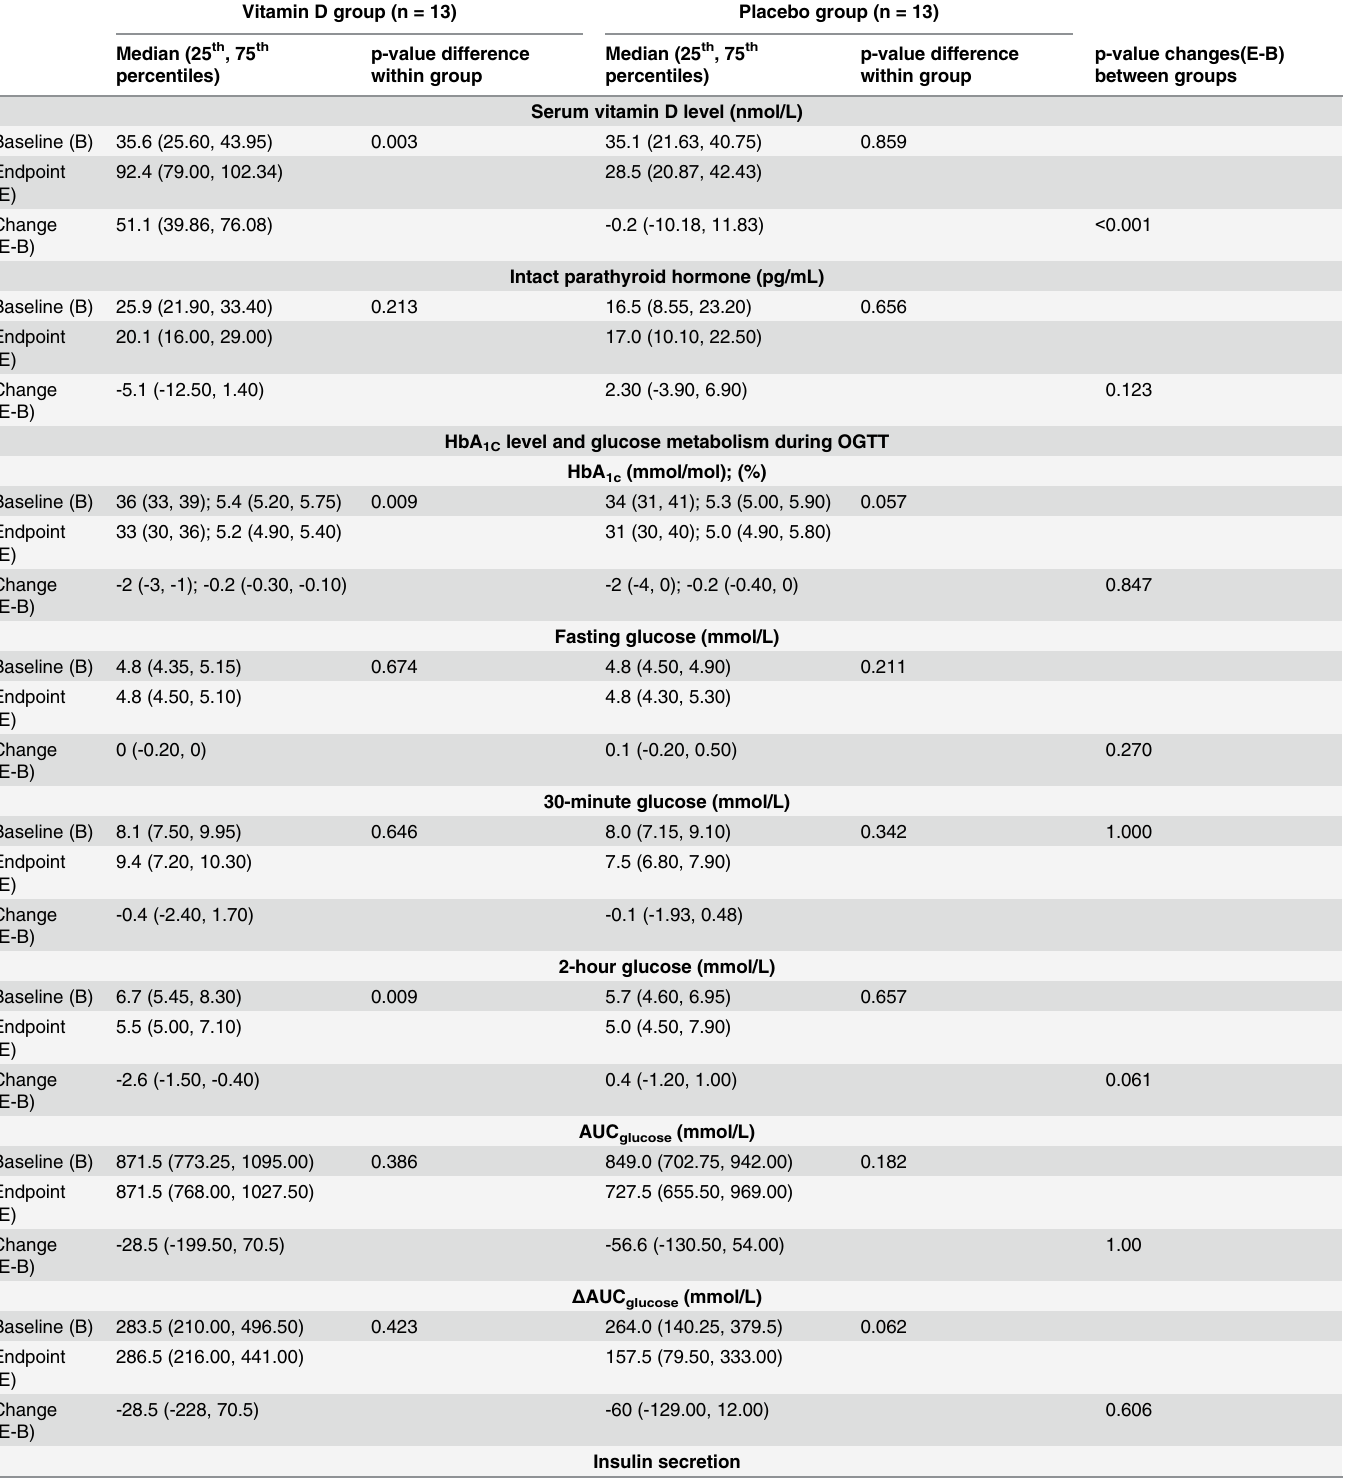
Table 2. Changes in vitamin D level, glucose and markers of insulin sensitivity and pancreatic beta-cell functions among women with former GDM in both interventional and placebo groups before and after intervention. Vitamin D group (n = 13) Placebo group (n = 13) Median (25 th , 75 th p-value difference Median (25 th , 75 th p-value difference p-value changes(E-B) percentiles) within group percentiles) within group between